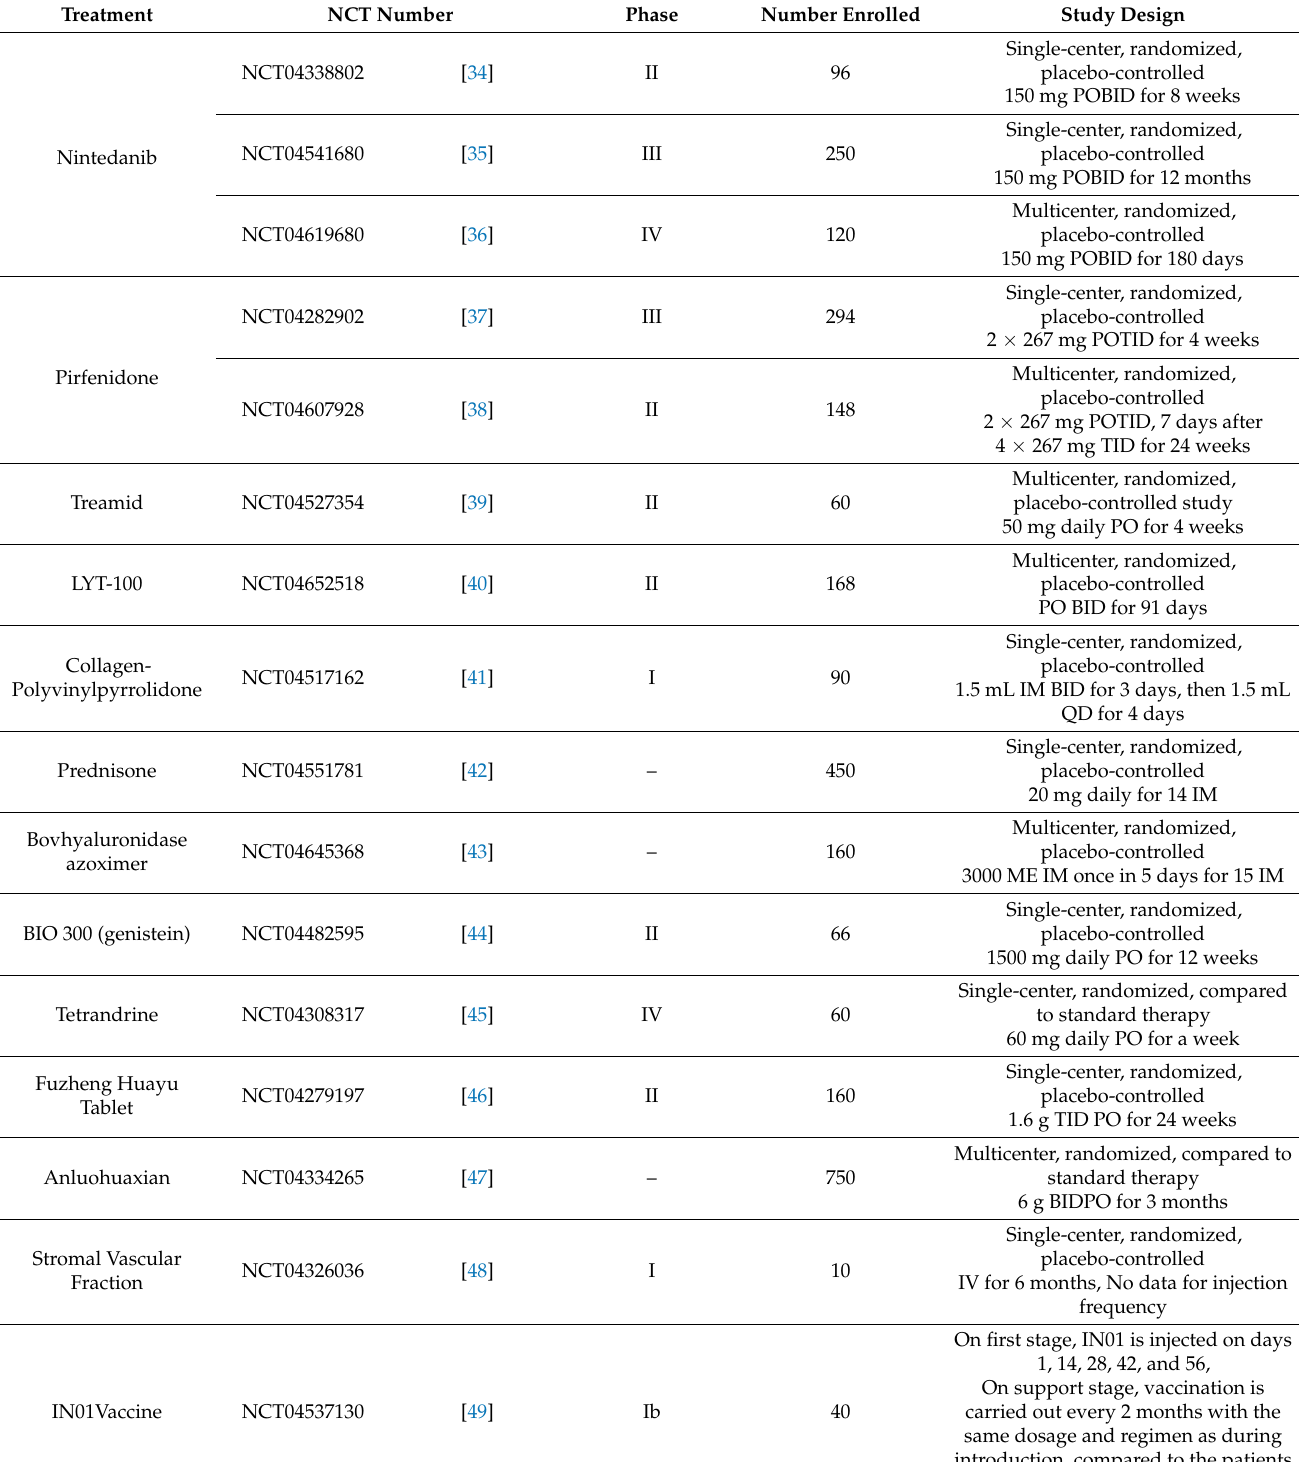
Table 1. Clinical trials of drugs for the treatment of post-COVID lung